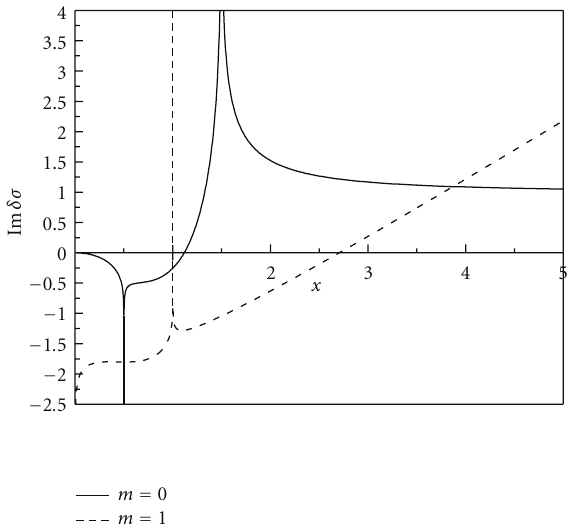
Figure 2: Dependence of Im δσ on x = ω/qυ 0 under η = 0 . 01, k a = 1, m = 0 (solid curve), and m = 1 q = k 0 , 0